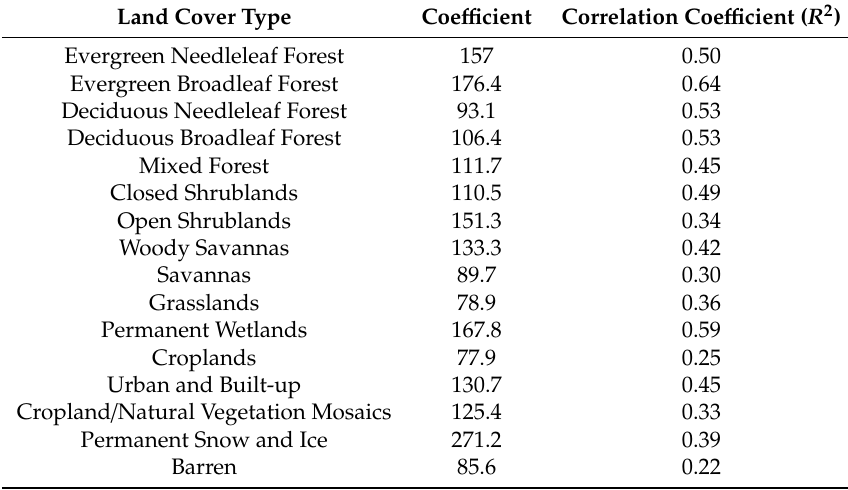
Table A1. Regression coe ffi cient between a vegetation index (MODIS normalized vegetation index (NDVI)) and a biomass simulated by the vegetation integrative simulator for trace gases (VISIT) terrestrial biosphere model [28] in each land cover type of the MODIS land cover type product (MCD12Q1) to estimate biomass. Biomass = a ∗ ln (NDVI) was used as a regression (where a is the regression coe ffi cient). The fire emission estimation process was reported in detail in previous study